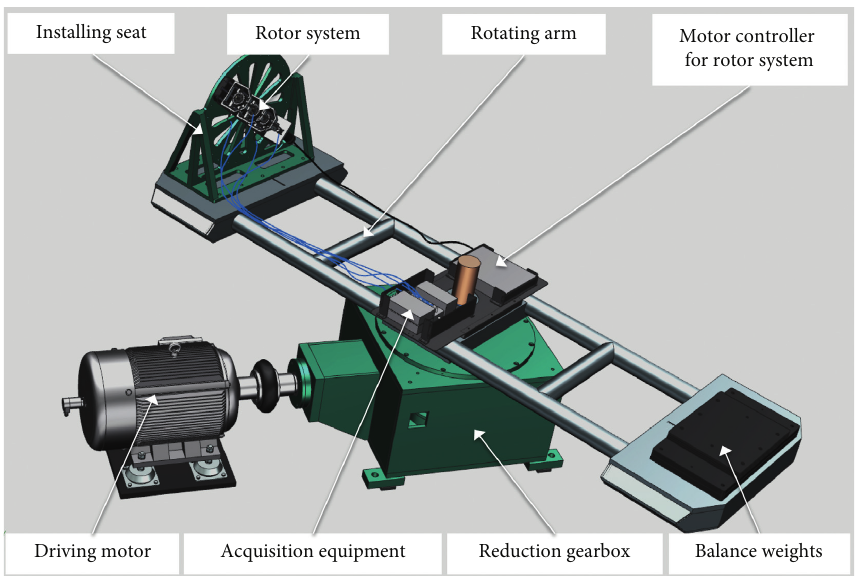
Figure 3: Test rig for simulating maneuver flight of a bearing-rotor system.